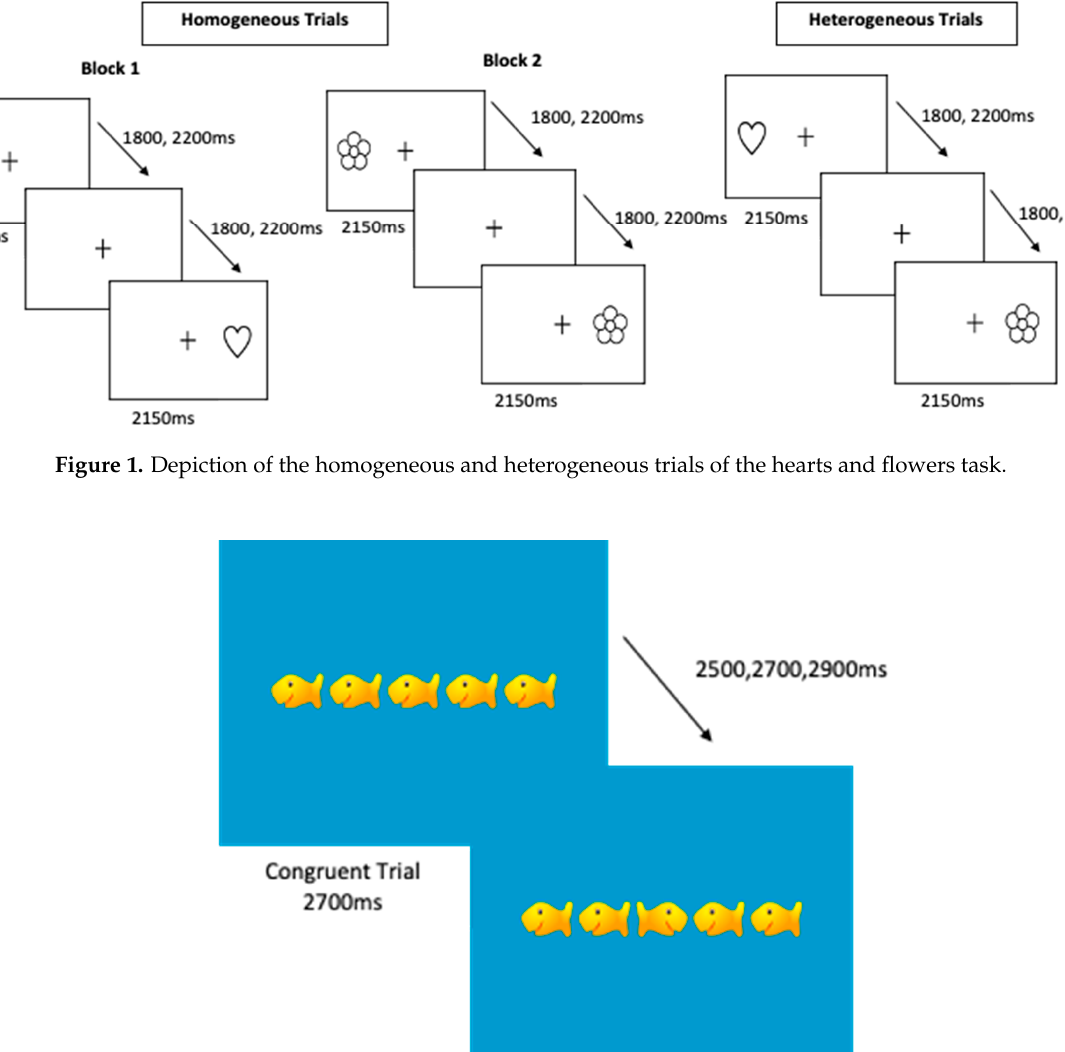
Figure 1. Depiction of the homogeneous and heterogeneous trials of the hearts and flowers task.